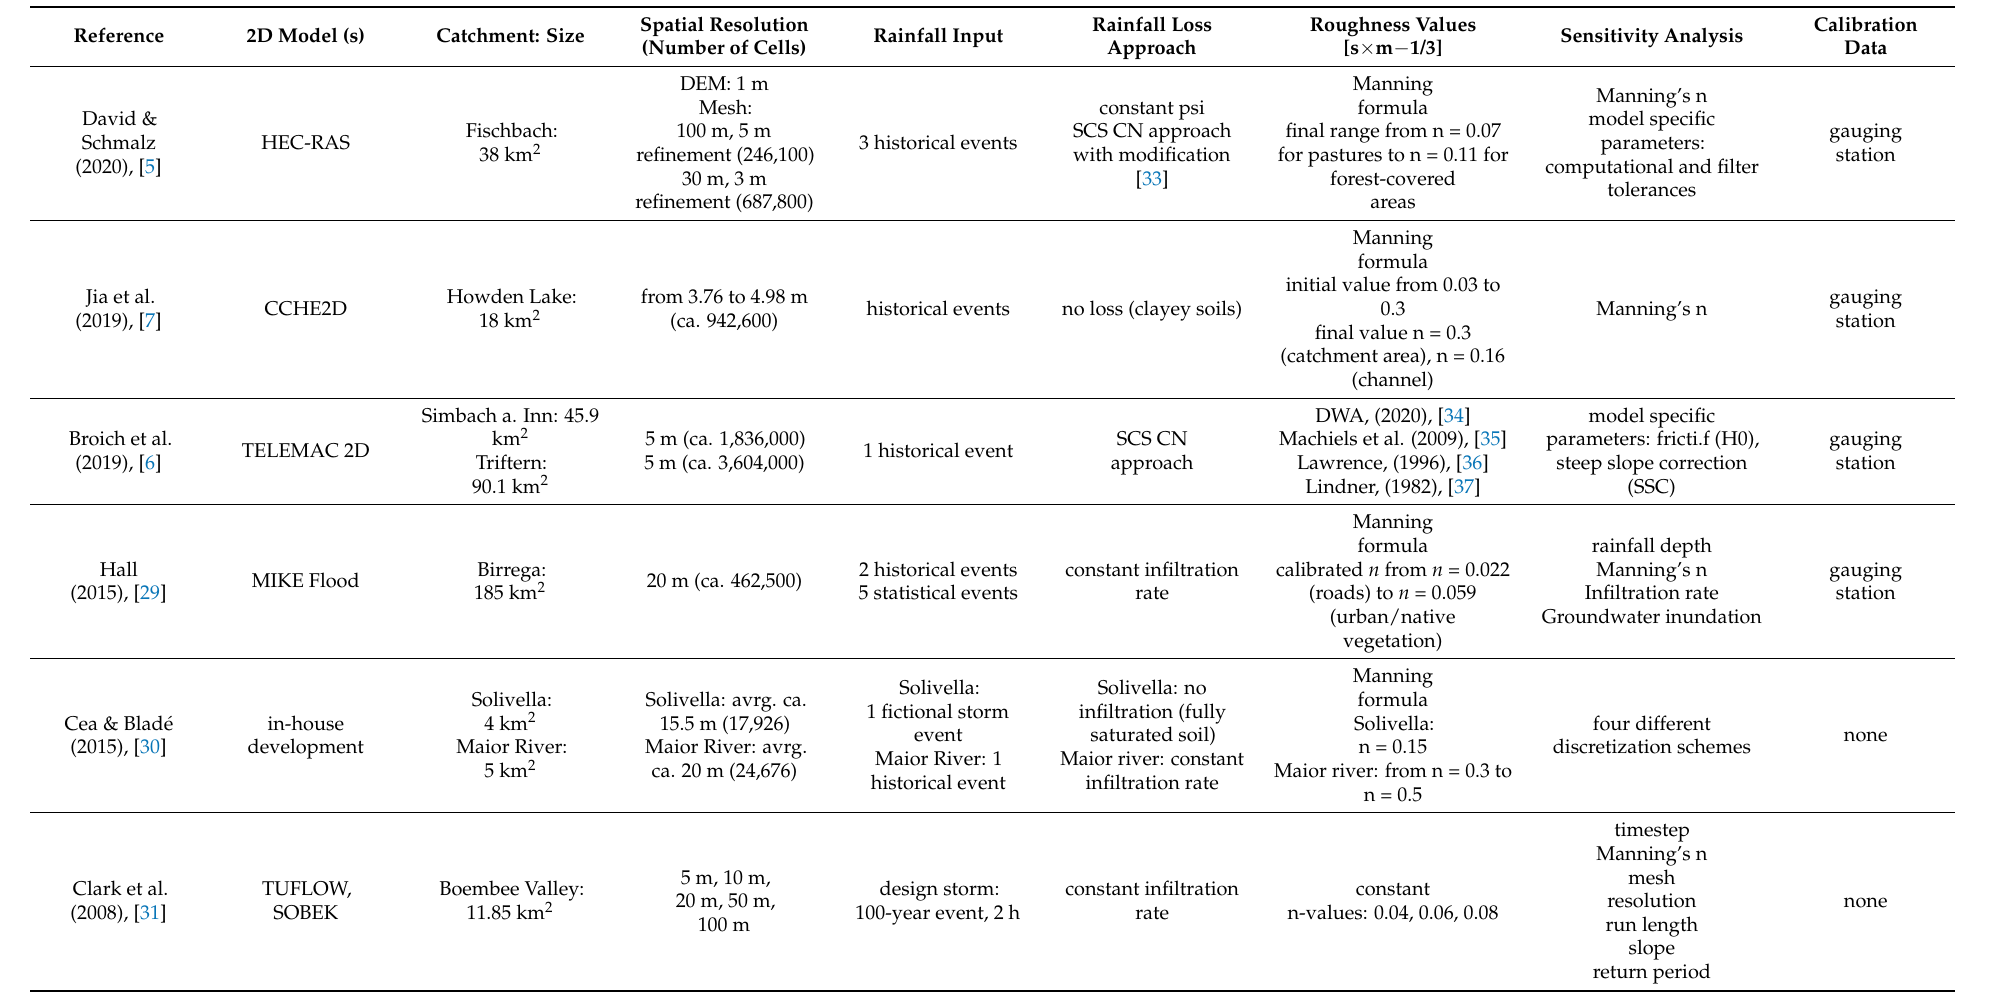
Table 2. Overview of case studies 2D rainfall–runoff modeling (‘Direct Rainfall Method’)—Rural